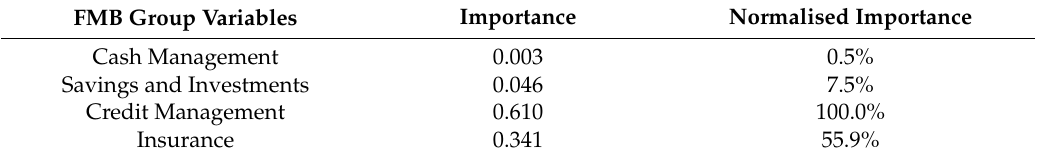
Table 9. Independent variable importance for Model D (calculated by the